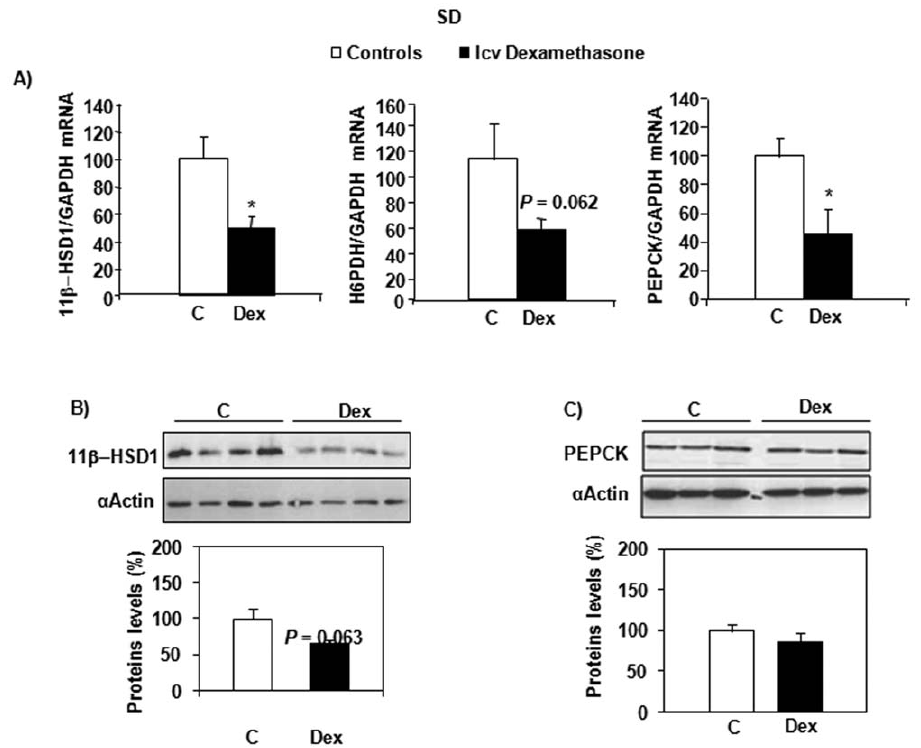
Figure 5. mRNA and protein expression of markers of GC action and gluconeogenesis in the liver of SD rats. Effects of central (icv) dexamethasone infusion for 2 days. A) Results are expressed as percent of relative mRNA expression compared to that obtained in control rats (100%). The analysis was performed in duplicate and the results were normalized with GAPDH expression. Mean 6 SEM of n =7–8 rats per group. * P , 0.05 compared to vehicle-infused control rats (Student’s t test). B and C) Representative Western blots of 11 b -HSD1 and PEPCK (n=4–5 per group). Quantification was performed using the ChemiDoc TM XRS and the Quantity One TM software.